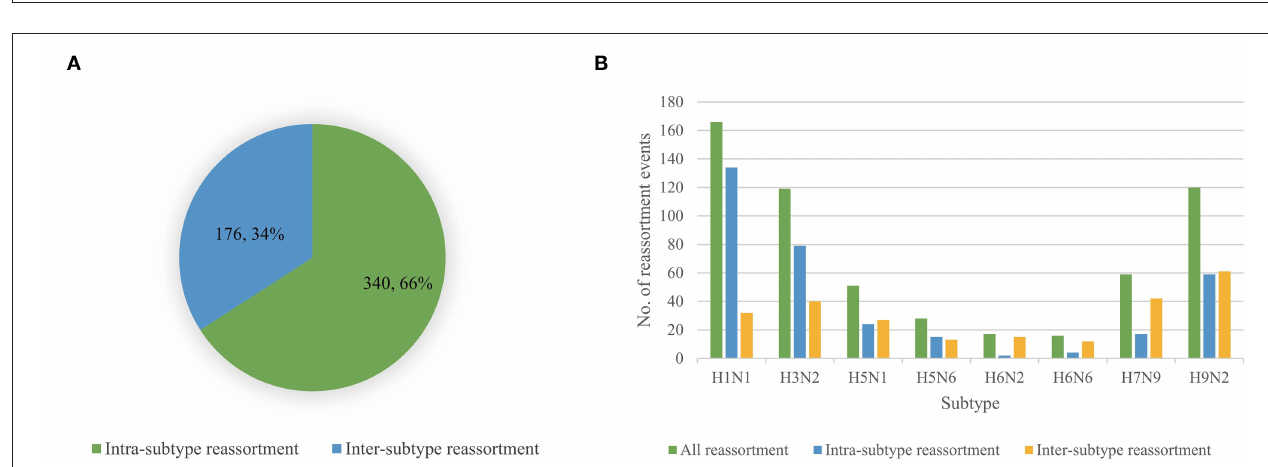
FIGURE 5 | (A) The number of intra-subtype reassortment and inter-subtype reassortment. (B) Statistic of all reassortment events, intra-reassortment events and inter-subtype reassortment events for H1N1, H3N2, H5N1, H5N6, H6N2, H6N6, H7N9, and H9N2.